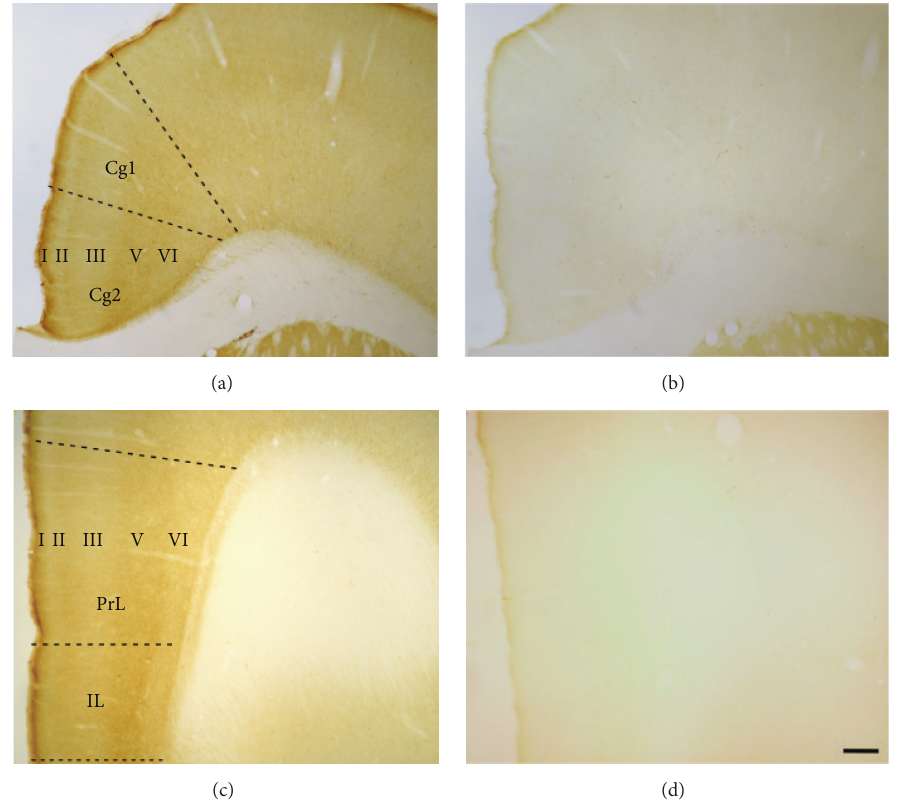
Figure 1: Microphotographs of the rat mPFC cortex showing PSA-NCAM immunostaining in control (a, c) and Endo-N treated rats (b, d). Pictures (a) and (b) show the dorsal (Cg1) and ventral cingulate cortices (Cg2) and pictures (c) and (d) show the infralimbic (IL) and prelimbic (PrL) cortices. Note in (b) the lack of PSA-NCAM expression in Cg1 and Cg2 (as observed in (d) for IL and PrL), but not in the striatum, demonstrating the effectiveness of Endo-N treatment. Roman numbers indicate cortical layers. Scale bar: 100 𝜇 m. Stereotaxic coordinates: Bregma +1.80mm, Interaural 10.80mm for figures (a) and (b); Bregma +3.00 mm, Interaural +12.00mm for figures (c) and (d)